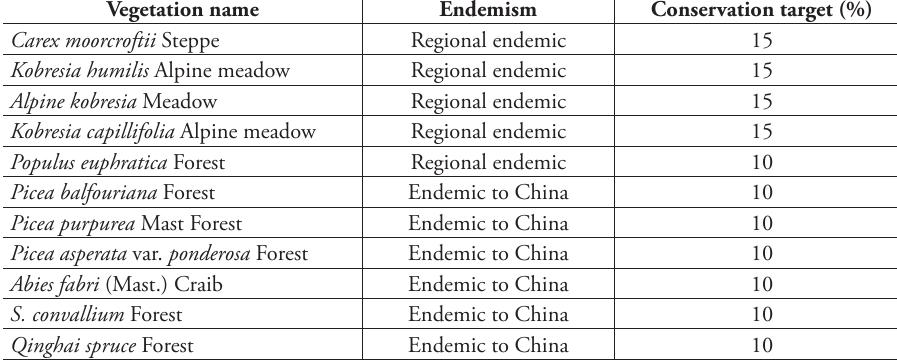
Table 1. Conservation targets for regional endemic or endemic ecosystems to China in Qinghai Province.